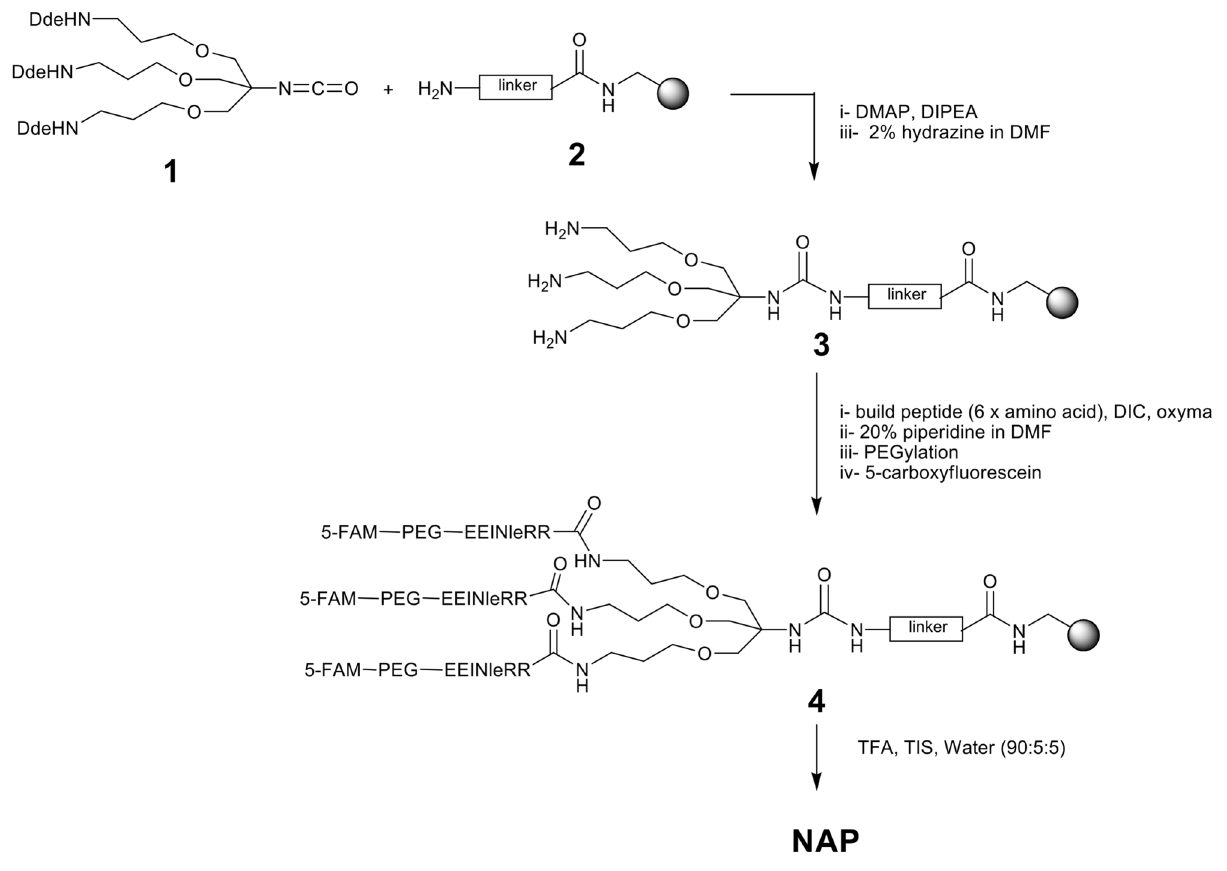
Figure 6. Synthesis of